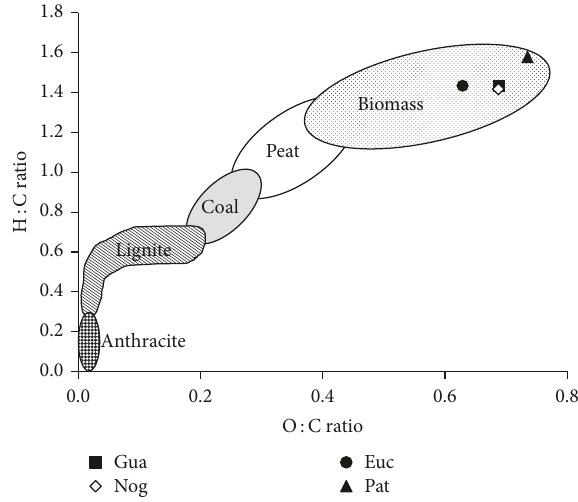
Figure 2: Van Krevelen